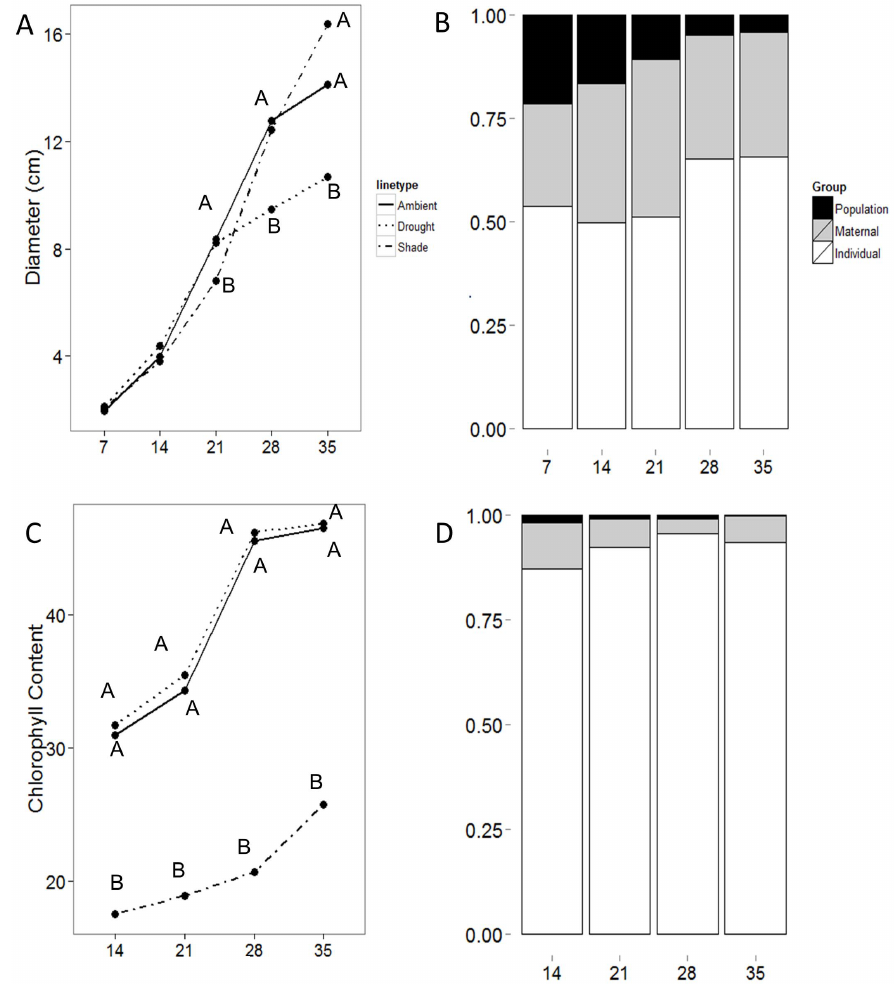
Figure 4. Change in average trait values in response to treatments (A and C; in each time period, letters indicate significantly different groups) and (B and D) the amount of variation attributed to population of origin, maternal line, and individual plant for diameter (top) and relative chlorophyll content (bottom).